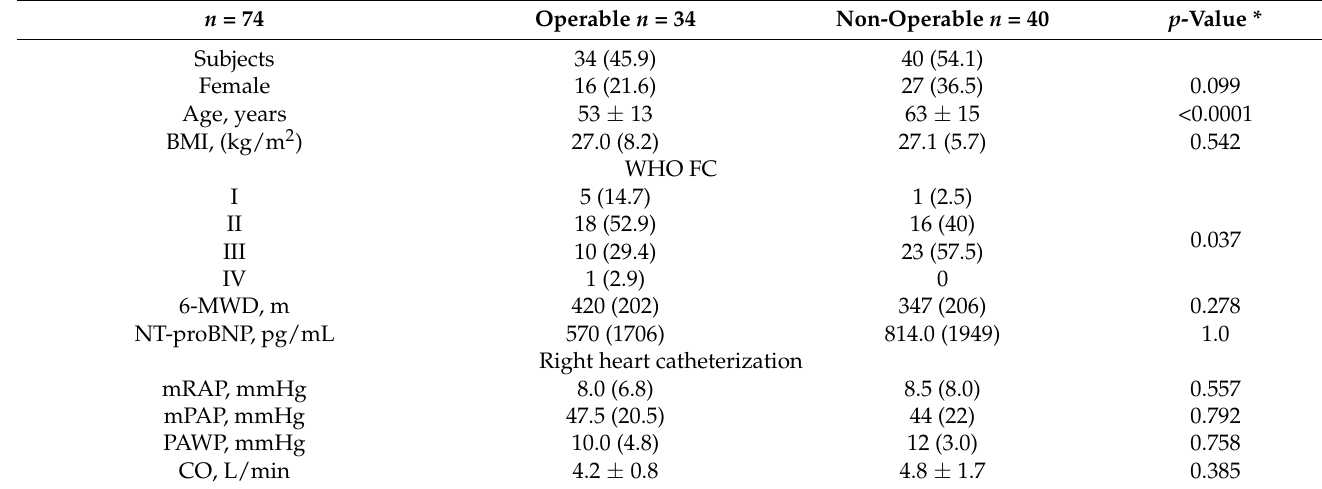
Table 5. Clinical, hemodynamic data and therapeutic management of patients with CTEPH according to their operability. Categorical variables are presented as frequency and percentage, n